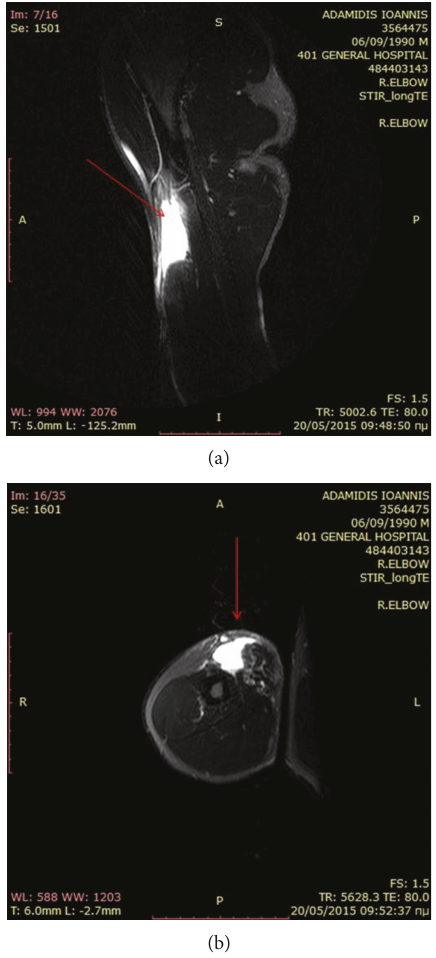
Figure 2: (a, b) MRI images showing an intrasubstance tear of the biceps brachii (arrows) with a large hematoma fi lling the